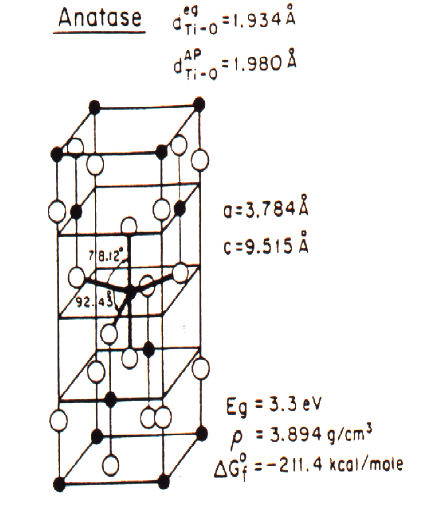
Figure 4. Structure of